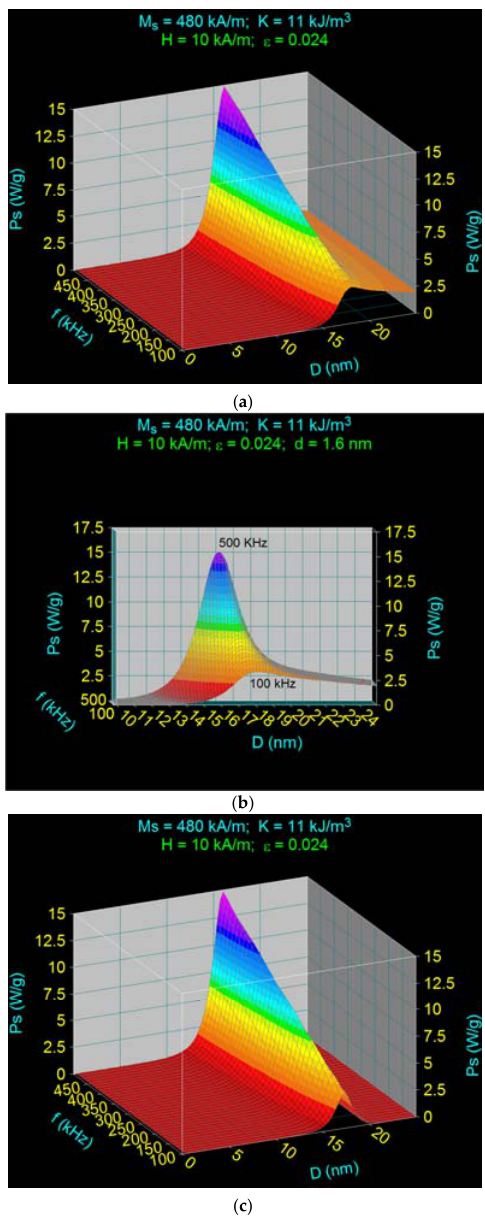
Figure 3. Specific loss power as a function of nanoparticle diameter and magnetic field frequency for Fe 3 O 4 – γ -CDs bionanoparticles dispersed in saline in ( a ) 3D and ( b ) 2D cases, and ( c ) for Fe 3 O 4